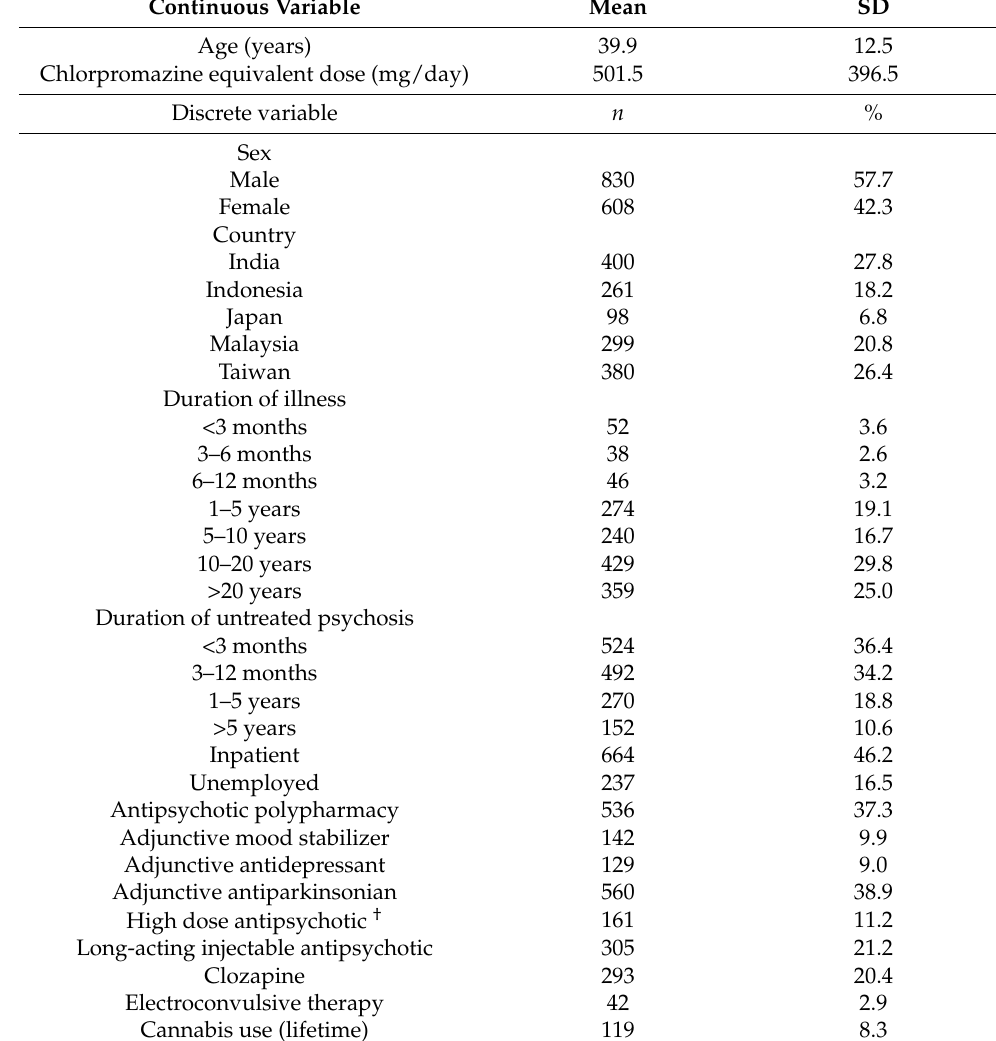
Table 1. General description of the study participants ( n =